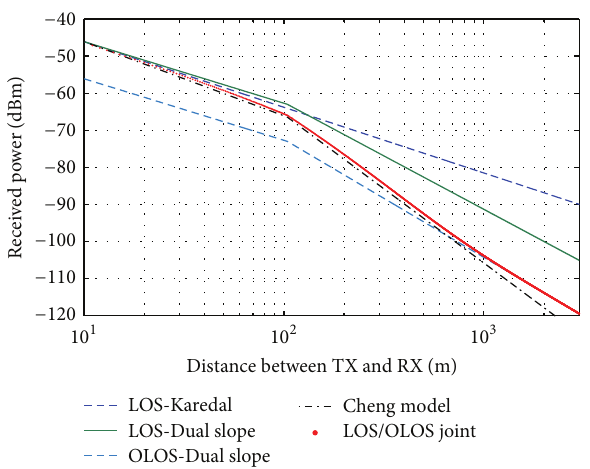
Figure10:TheprobabilityofsuccessfulpacketreceptionforaCSTH of −